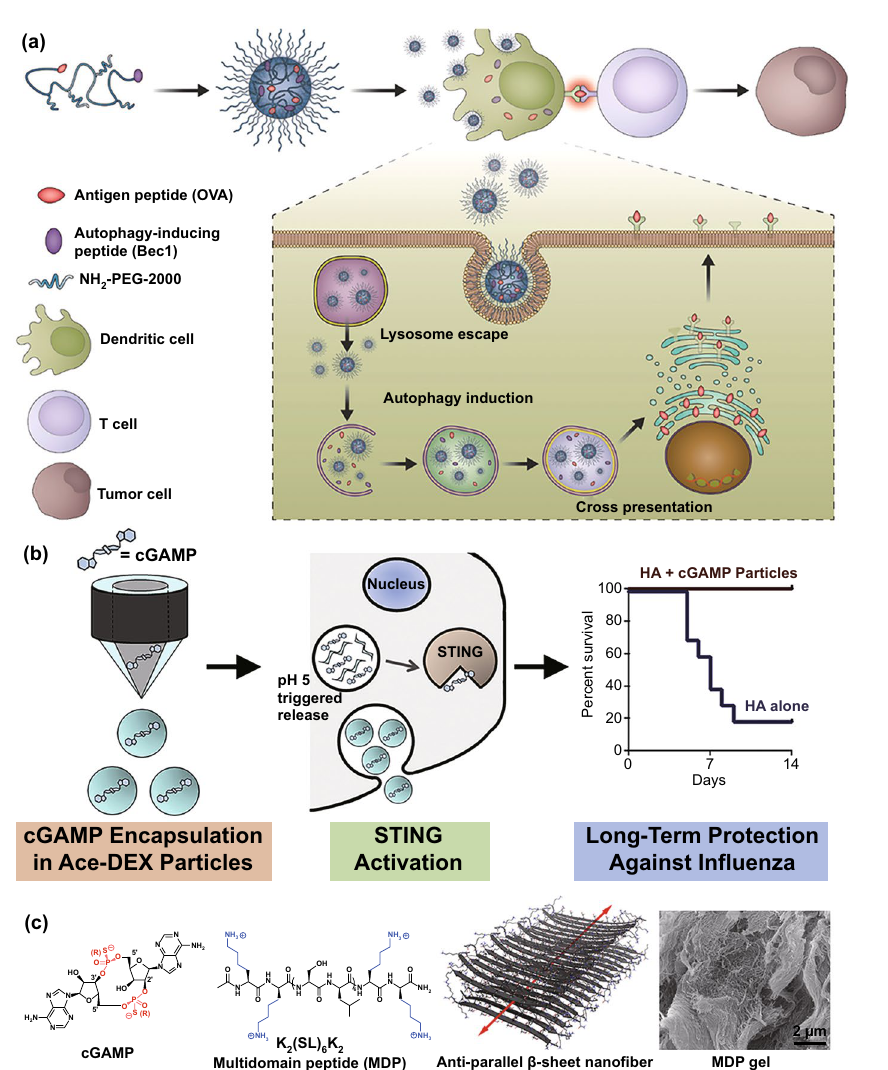
Fig. 2 Nanomedicines for cGAMP. a In vivo up-regulation of the autophagy pathway in DCs via a nano-activator comprising the antigenic peptide and autophagy-inducing peptide (Bec1). Reproduced with permission from Ref. [77]. b pH-sensitive acetylated dextran (Ace-DEX) polymeric microparticles. Reproduced with permission from Ref. [73]. c Anti-parallel β-sheet nanofibrous hydrogels. Reproduced with permis- sion from Ref.